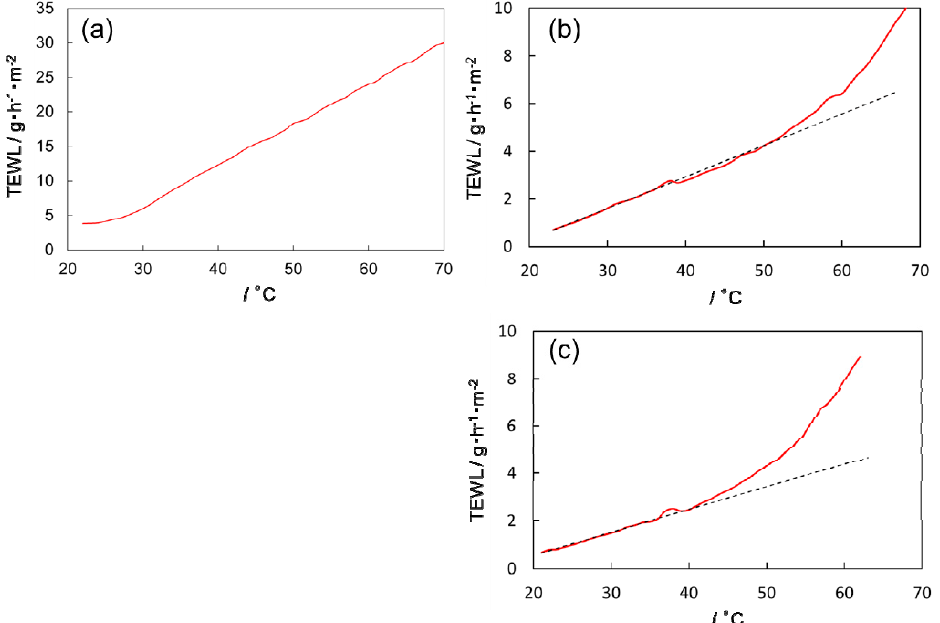
Figure 3. Temperature dependence of TEWL in ( a ) a membrane filter in heating, ( b ) an SC sheet in heating, and ( c ) an SC sheet in cooling. The output value of Tewameter without correction is plotted as the TEWL (transepidermal water loss) value. The scanning rate of temperature was 0.6 K / min. The data was acquired every 10 s and smoothed by the moving average method. The dashed lines in ( b , c ) are calculated by linear regression of the data at low temperature region and shown as a guide for eyes.